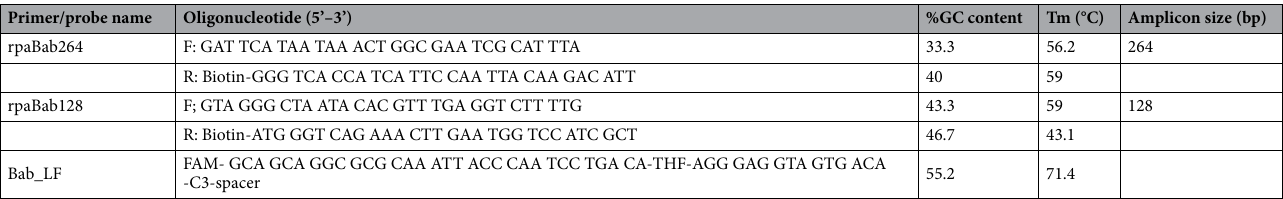
Table 1. Primer and probe sequences used in this study. F forward, R reverse, LF lateral flow, FAM carboxyfluorescein, THF tetrahydrofuran spacer, C3 spacer polymerase extension blocking